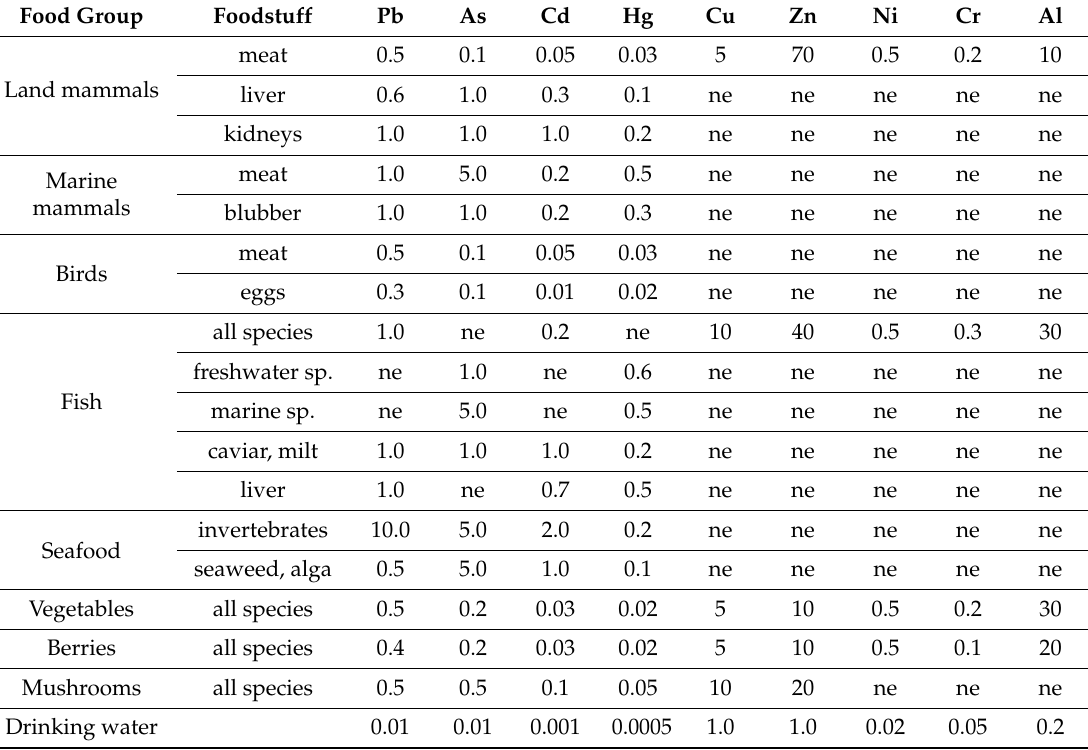
Table 4. Russian allowable levels of metals in raw foods, mg/kg ww, and in drinking water,